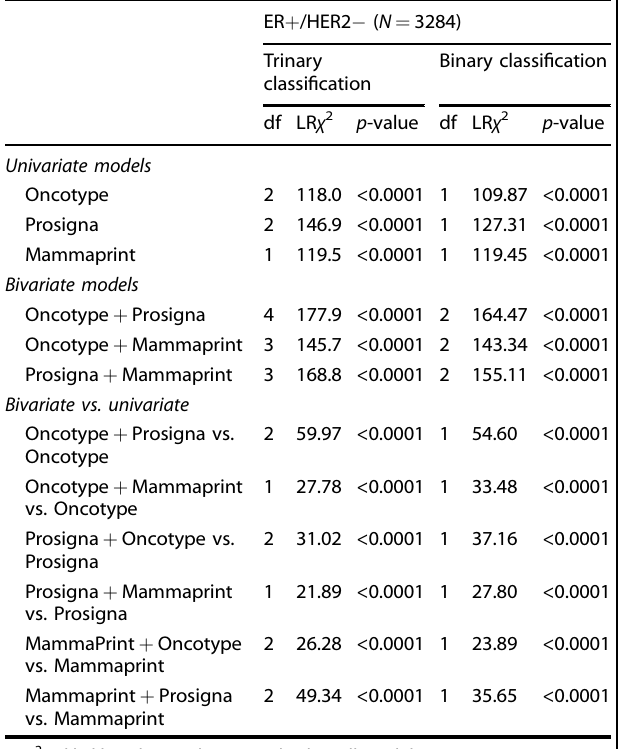
Table 1. Likelihood χ 2 ratios by test and